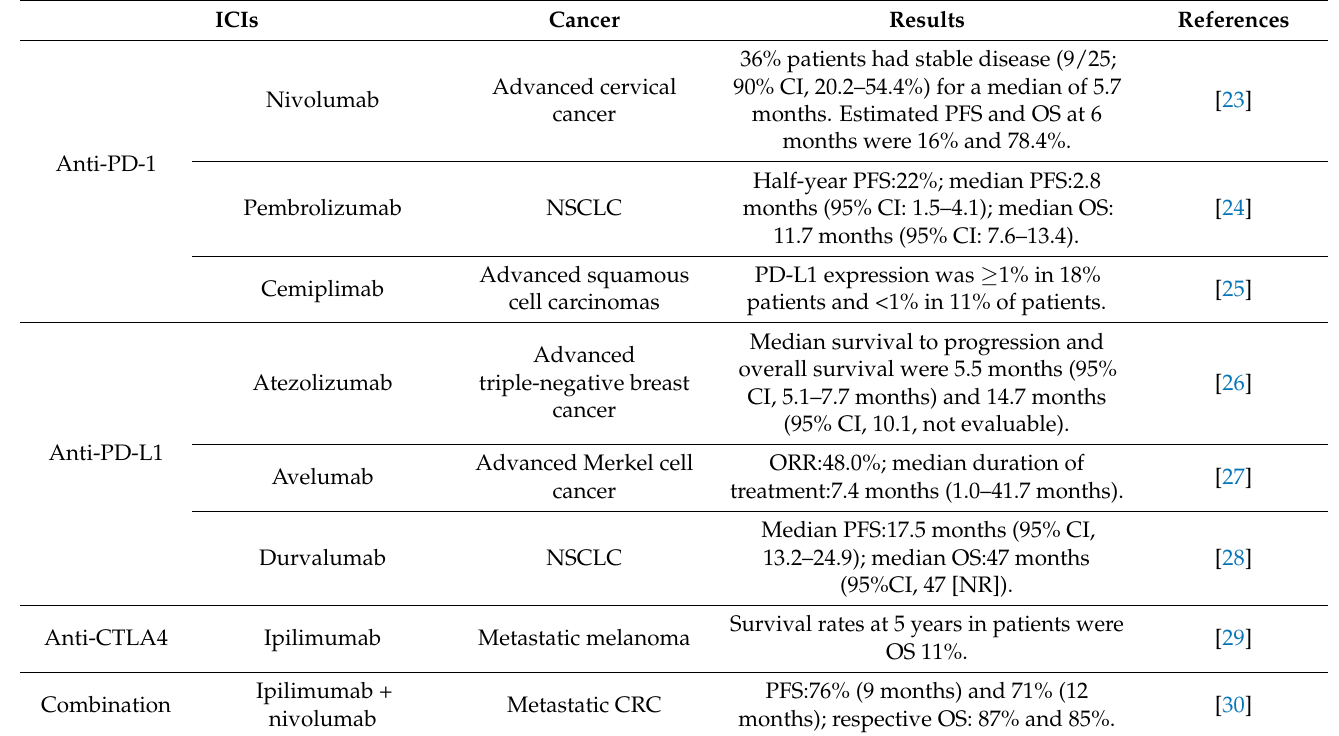
Table 1. Some solid tumors receiving